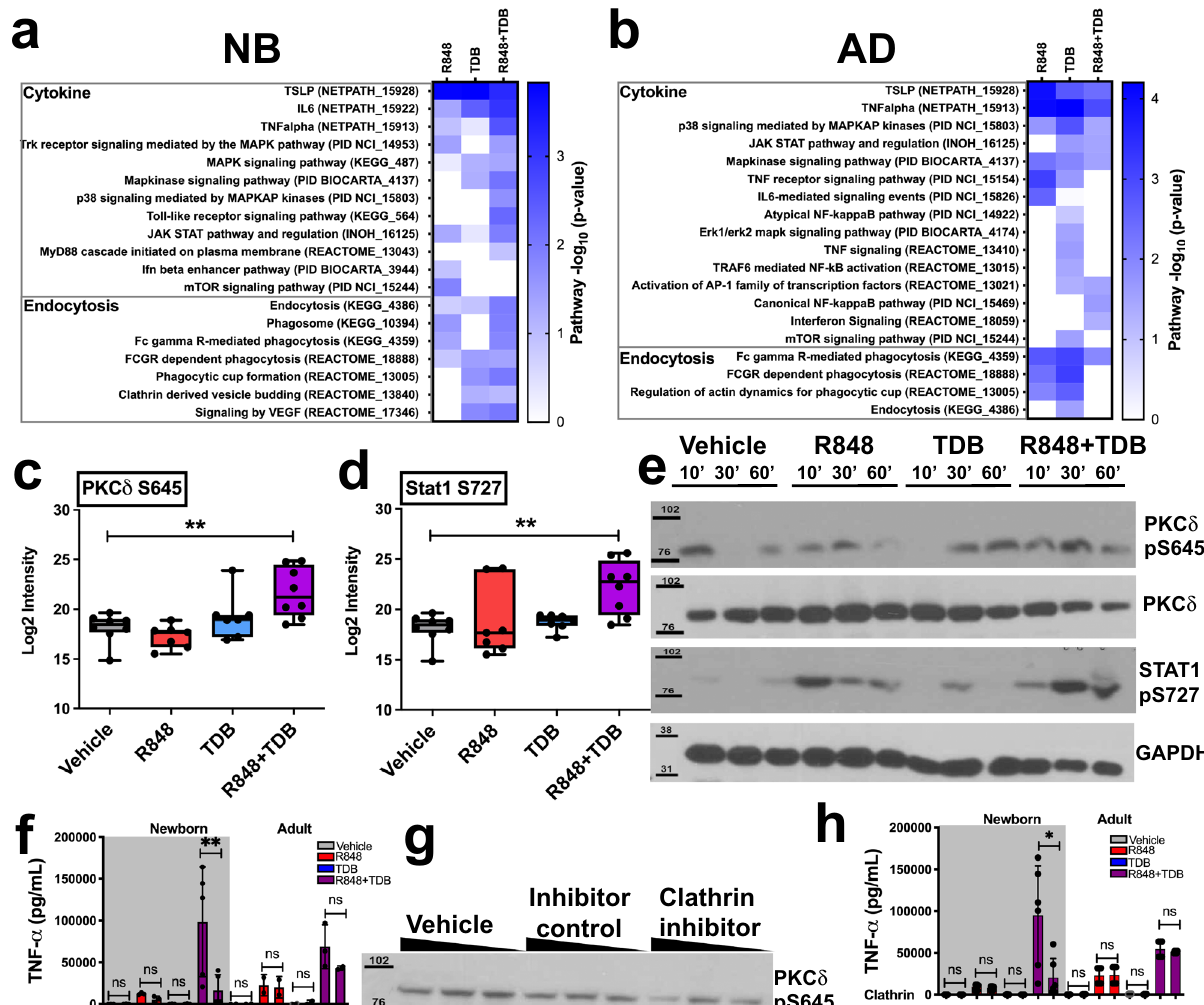
Fig. 1 Phosphoproteomic analysis and use of targeted inhibitors in human MoDCs reveals a role for endocytosis in synergistic enhancement of cytokine production in newborns. Newborn and adult MoDCs were stimulated with 50 µ M R848, 100 ug/ml TDB, combination, or vehicle control for 30 min. a , b Pathway overrepresentation analysis (hypergeometric test with Benjamini Hochberg correction) of phosphopeptides quanti fi ed through mass spectrometry reveals synergistic enrichment of both cytokine- and endocytosis pathways by R848 + TDB in newborn, but not adult, cells (hypergeometric test). Signi fi cant increase in phosphorylation (paired Student ’ s t test) in newborn MoDCs of PRKCD at Ser645 and its substrate, STAT1 at Ser727, ( c , d ) are shown using box-whisker plots (center:mean, boxes:75th and 25th percentile, whiskers: minimum and maximum values) was con fi rmed by western blotting ( e ), demonstrating prolonged phosphorylation of these two residues after stimulation with R848 + TDB. f – h Inhibition of endocytosis with a clathrin inhibitor reduced PRKCD phosphorylation and subsequent TNF- α production by neonatal MoDCs. n = 9 newborns, 4 adults, error bars indicate mean + SEM. Statistical comparisons in ( c , d , f , and h ) are indicated by connecting lines and employed two-tailed Wilcoxon rank-sum test (* p < 0.05, ** p < 0.01, *** P < 0.001). Source data are provided as a Source Data fi